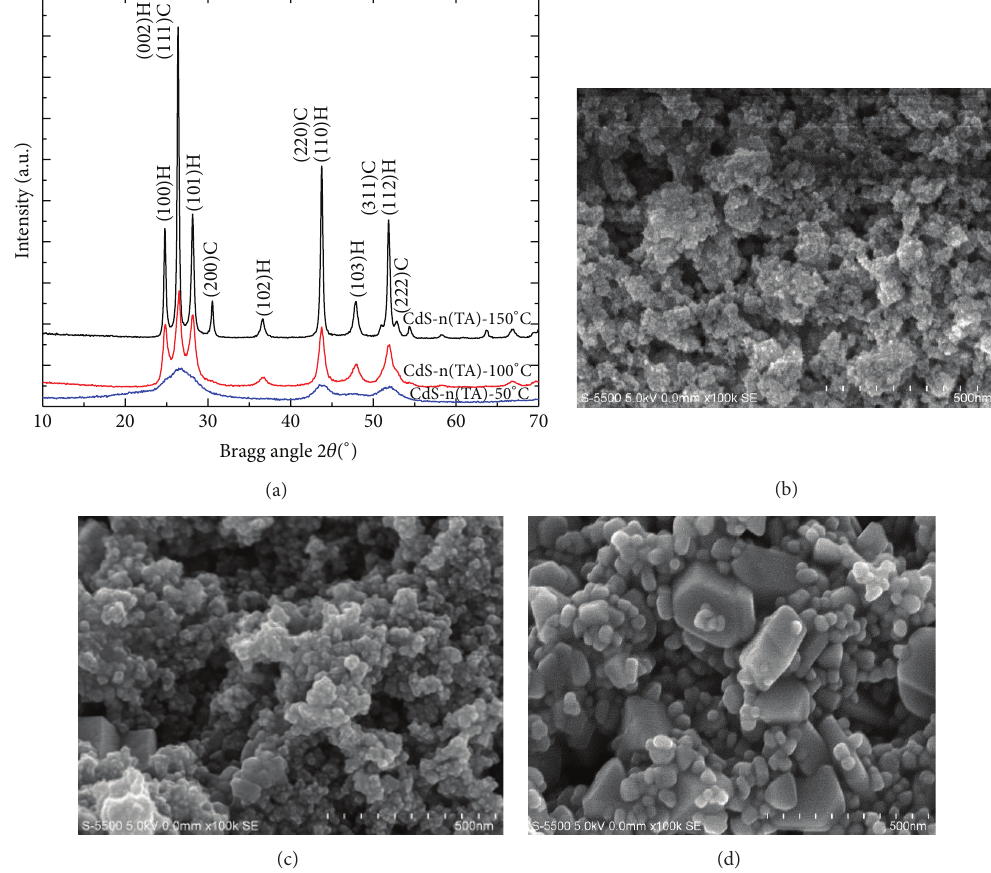
Figure 1: (a) XRD patterns and SEM micrographs of CdS-n(TA) products synthesized at (b) 50 ∘ C, (c) 100 ∘ C, and (d) 150 ∘ C for 30